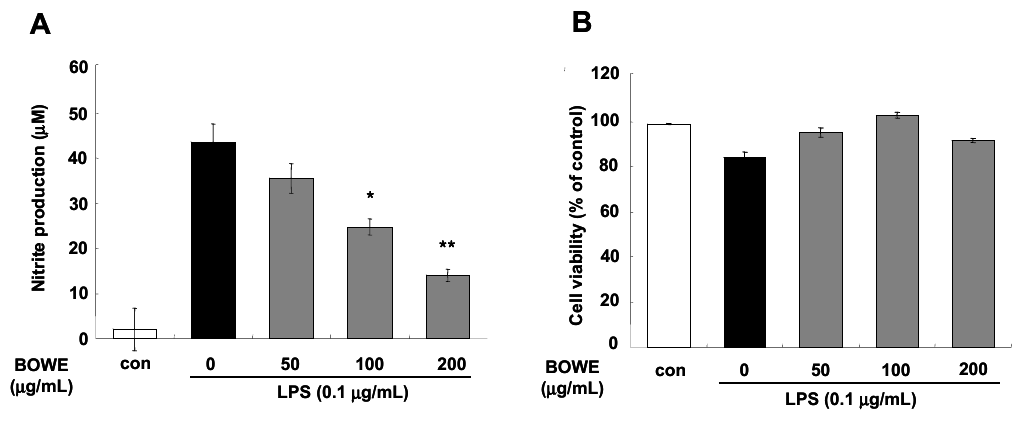
Figure 1. Effect of BOWE on LPS-induced NO ( A ) and cell viability assay ( B ): BV-2 cells were pretreated with or without the indicated doses of BOWE for 4 h and then stimulated with LPS (0.1 μ g/mL) for 18 h. The culture supernatants were subsequently collected and analyzed for nitrite levels. The cell viability was determined by CCK assay. Data are presented as the means ± SEM of triplicates from separate experiments. * p < 0.05 and ** p < 0.01 denote significant differences compared to the group treated with LPS